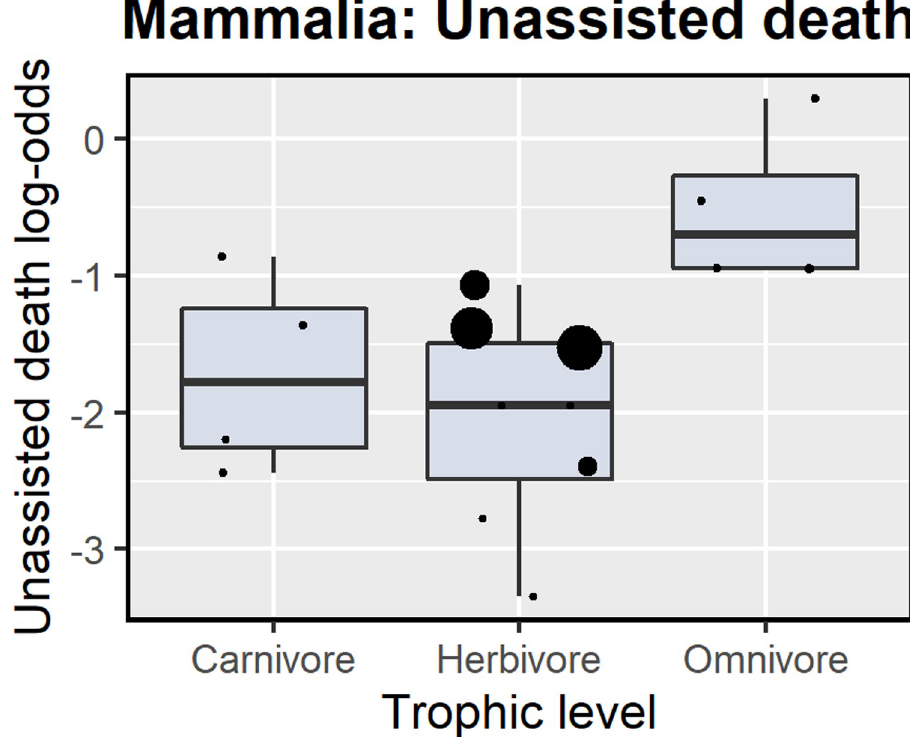
Fig 2. Distribution of log-odds across factors affecting unassisted death rates for mammalian species. Note that each point represents the log-odds of survival of one study-species combination, and the size of the point is proportional to the inverse variance of the log-odds (i.e. larger points have more